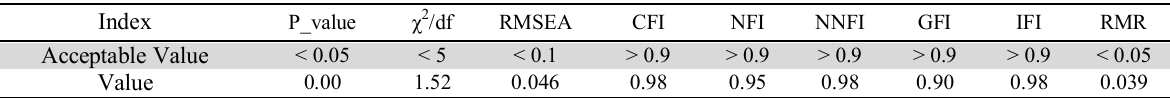
Fit indexes of model